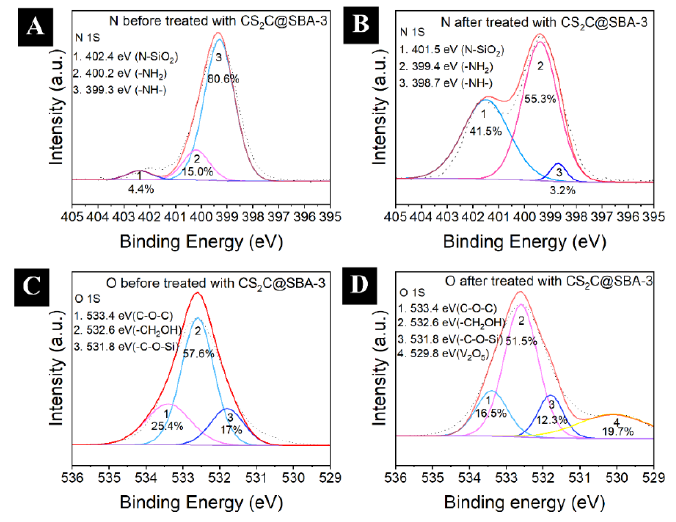
Figure 10. The XPS high − resolution of N 1S of CS 2 C@SBA − 3 before adsorption ( A ), and after adsorption ( B ). The XPS high − resolution of O 1S of CS 2 C@SBA − 3 before adsorption ( C ), and after adsorption ( D ). Conditions: V(V) initial concentration = 100 ppm, CS 2 C@SBA − 3 dosage = 1.0 g/L, pH value = 3.0, experimental temperature = 298 K, contact time = 24